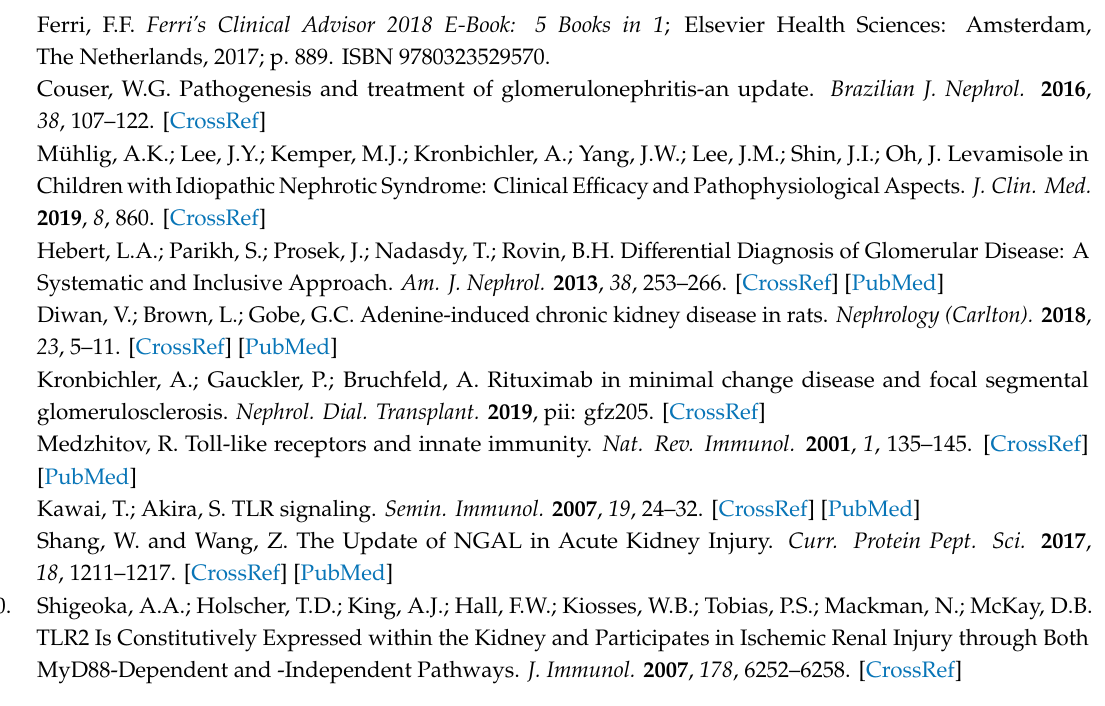
Figure A3. Sample analysis for isotype control CD4+, CD8+, and CD19+ receptors ( A , B , C ).